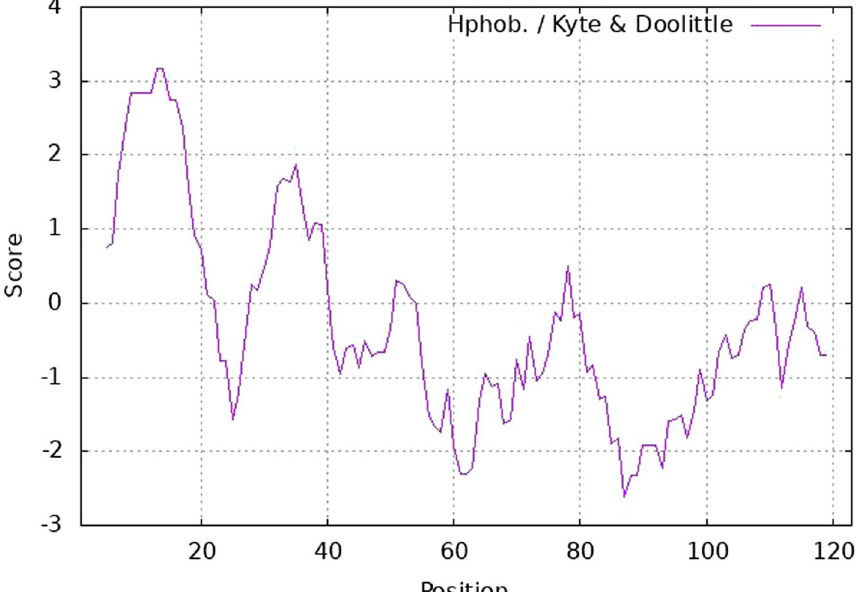
Fig. 2 Kyte-Doolittle plot showing hydrophobicity of Pp -ALF. The peaks above the score of 0.0 indicate the hydrophobic nature of the peptide